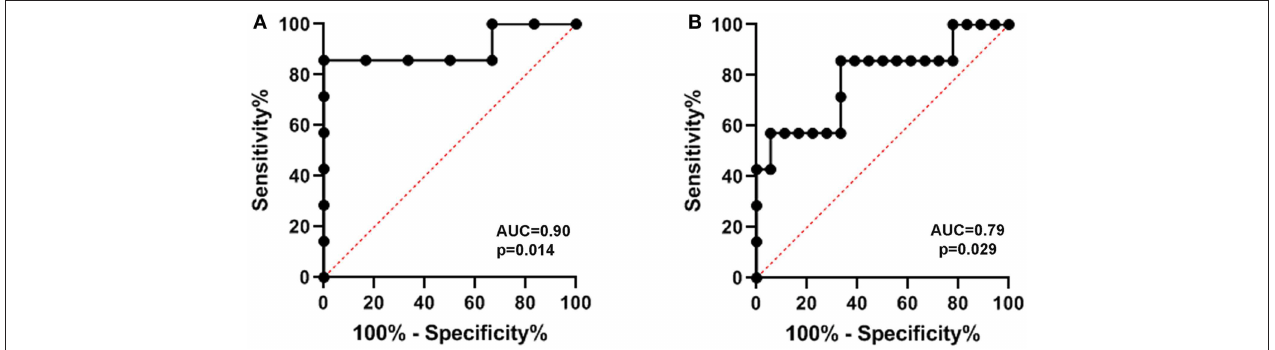
FIGURE 3 | Serum SNTF on the day of mTBI predicts impaired long-term recovery of cognitive function under stress. Serum levels of the biomarker were evaluated a minimum of 4 times, and analyzed in relation to brain functional measures by Mann-Whitney U test. Recovery of cognitive stress function was determined as the difference in the Stroop Color and Word IS-T scores between 90 and 30 days post-injury. In ROC-AUC analyses, serum SNTF on the day of injury was significantly higher in mTBI with the decile exhibiting the worst functional recovery compared to either the best recovering decile (A) or best recovering quartile (B) .